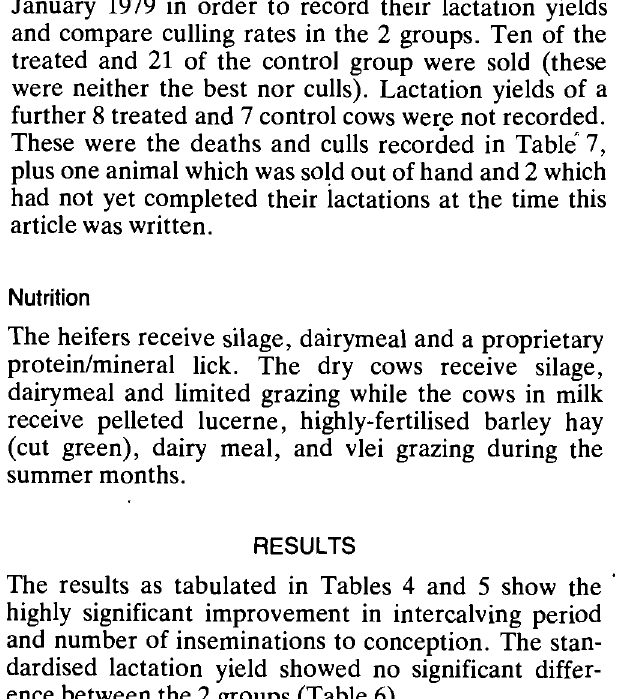
Table 6: STANDARDISED LACTATION YIELD (AVERAGE)